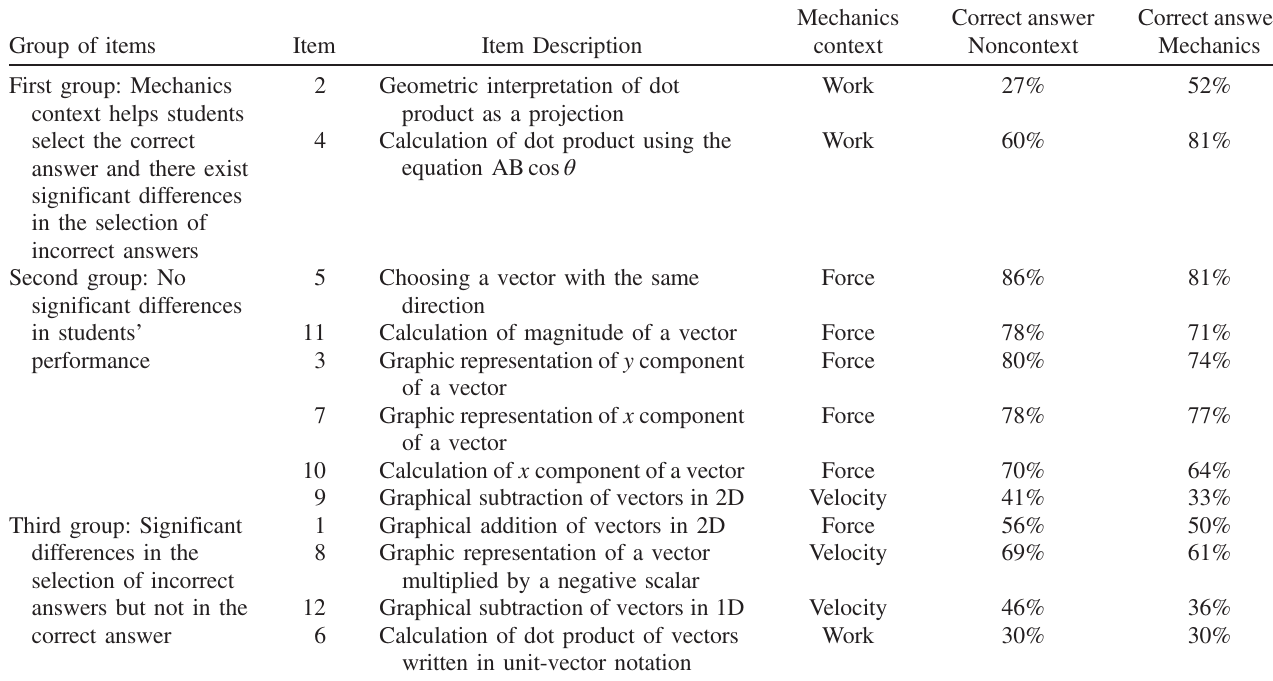
TABLE III. Classification of items according to the differences in students ’ performance. Note that to determine which specific option was significantly different we use the chi-square test with a p value of 0.01 (adjusted by the Bonferroni correction). Group of items